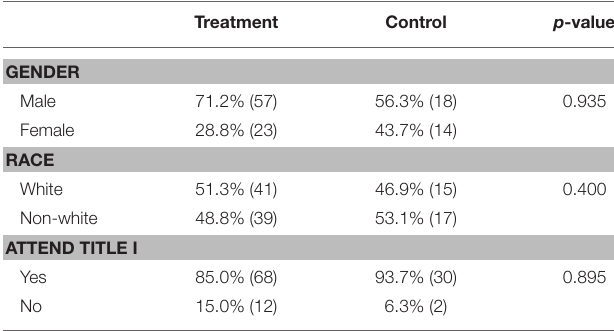
TABLE 1 | Demographic comparison of treatment and control